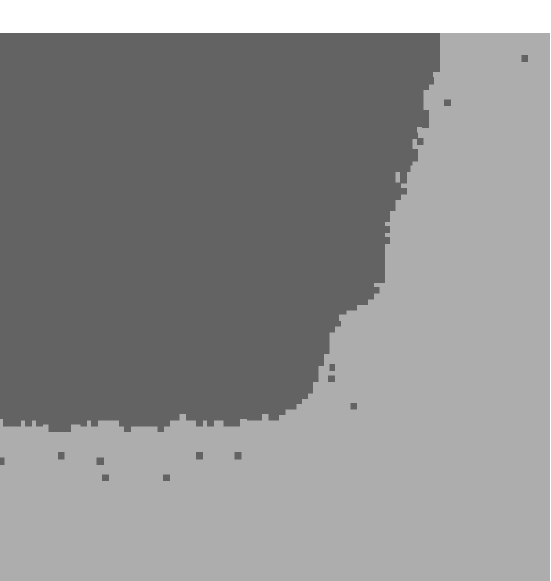
Fig. 2. Computer-simulated pattern demonstrating potential problems in assessing the simulation parameters by analysing the morphologic pattern only. The real simulation values were COHESION = 0.18, GROWTHFACT = 2.90, MOTILITY = 6 and TUMOURDESTRUCT = 0.05. The estimation results concerning MOTILITY and TUMOURDESTRUCT are shown in Table 6. Though the pattern appears to be compatible with the whole range of MOTILITY and TUMOURDESTRUCT, the combination of high MOTILITY with low TUMOURDESTRUCT – which would yield a less compact pattern – and the combination of low MOTILITY with high TUMOURDESTRUCT – which would not show individually scattered cells beyond the tumour bulk – can be ruled